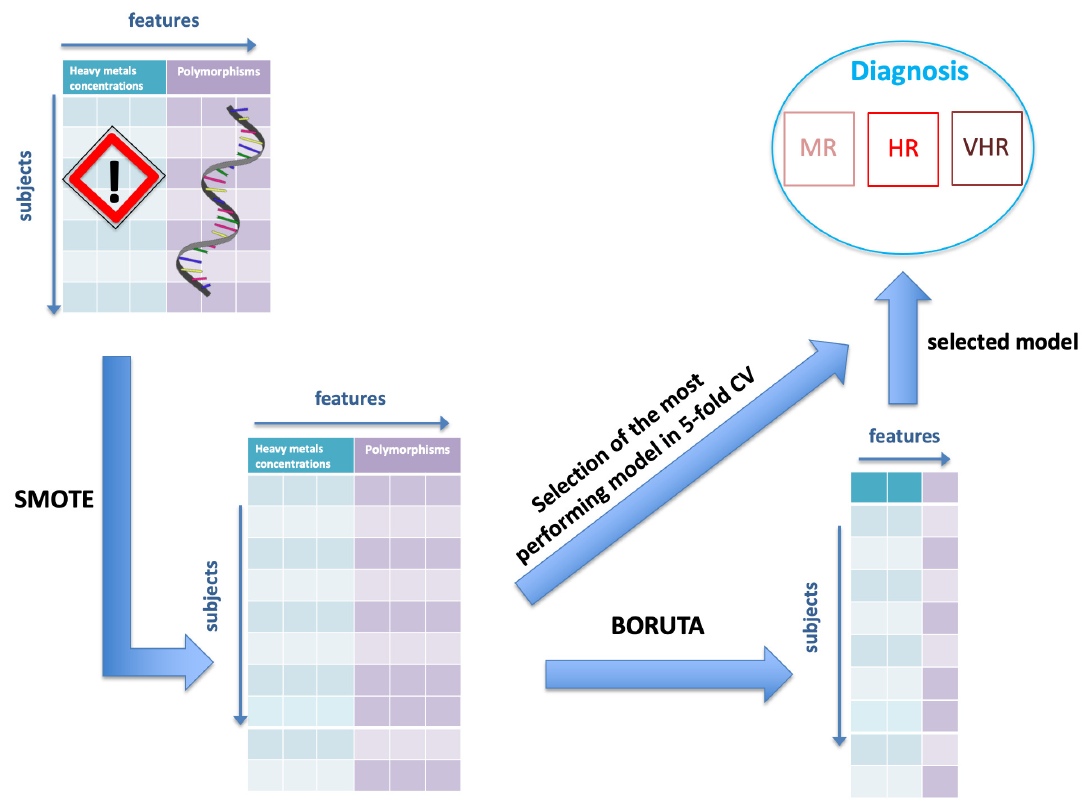
Figure 2. Pictorial representation of the implemented classification procedure. After balancing the dataset through SMOTE method, we selected the most efficient feature subset by means of Boruta algorithm and the most performing learning model in 5-fold CV. We used the chosen feature array to feed the selected classifier and distinguish the three-levels CVD